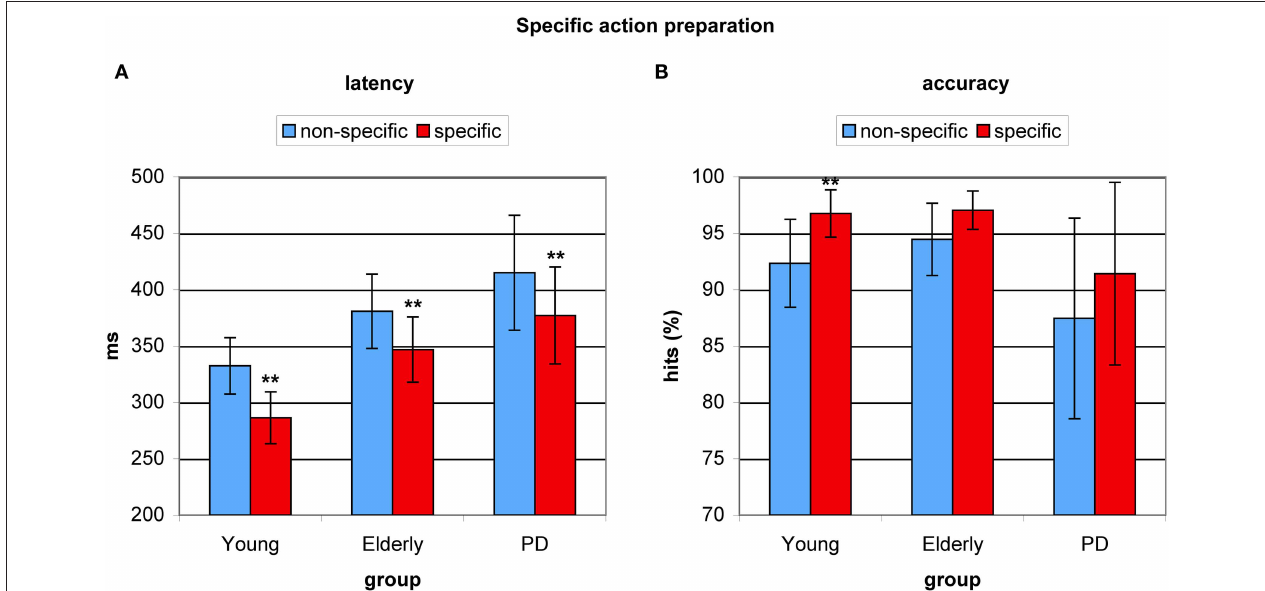
Figure 4 | Benefits from specific spatial preparation in young healthy participants, healthy elderly, and Parkinson’s patients (PD). (A) Average antisaccade onset latency was significantly faster on specific spatial preparation trials (red) than on trials where a neutral instruction cue was